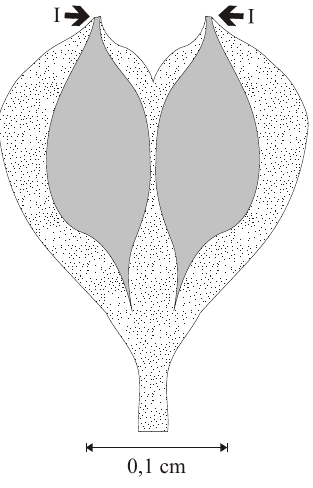
Fig. 6 – Hypothetical reconstruction of the bract-scale complex of Coricladus quiteriensis sp. nov., with the seeds adpressed in anatropous position (I).